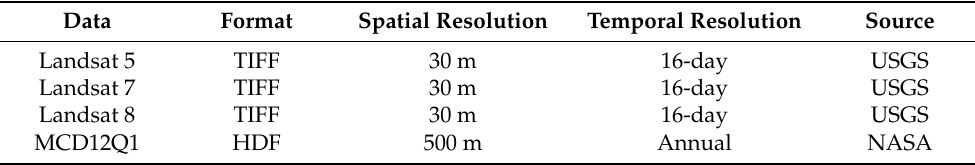
Table 1. Detailed description of remote sensing